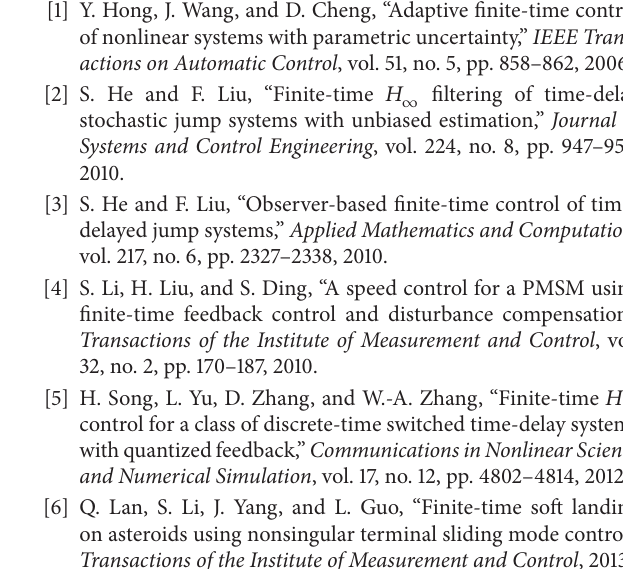
Figure 2: 𝑥(𝑘) of open-loop system.